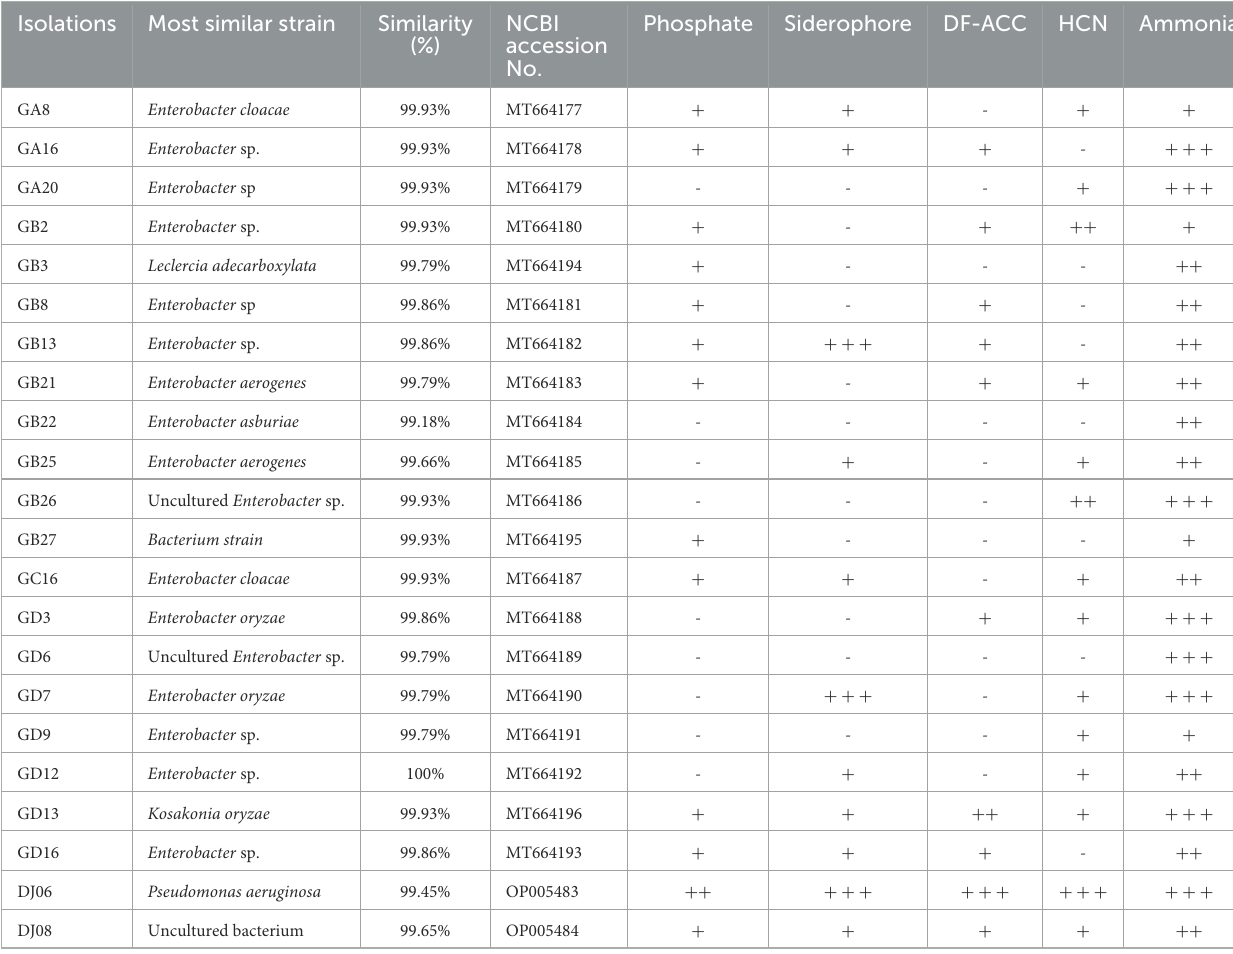
TABLE 2 PGP activities of selected endophytic strains from the sugarcane roots. Isolations